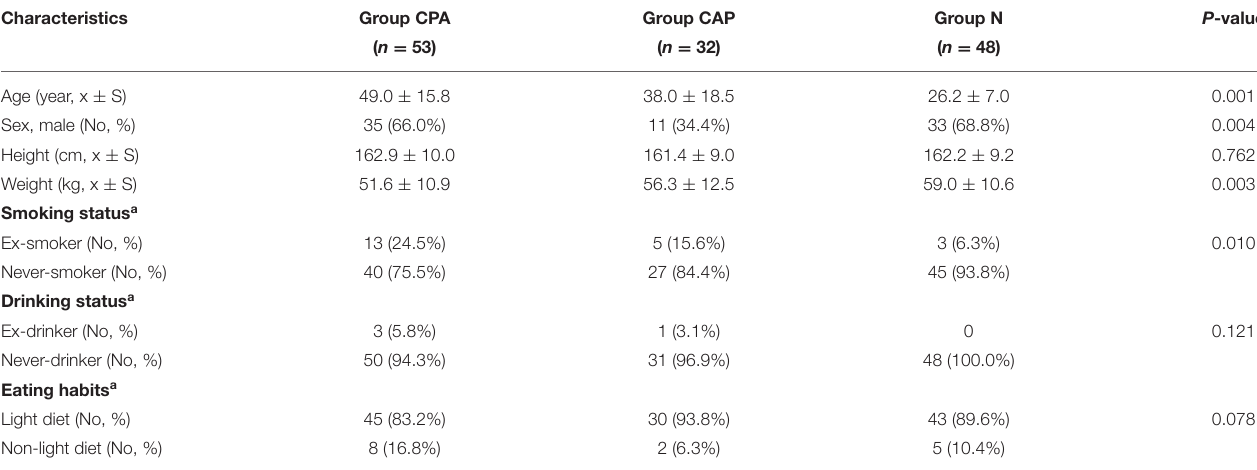
TABLE 1 | Baseline characteristics of the study participants.